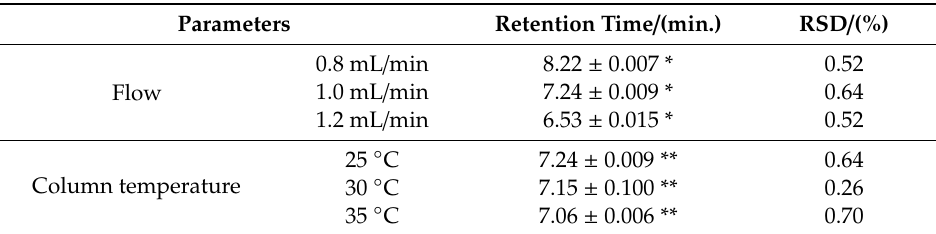
Table 3. Results of the robustness for quantification of